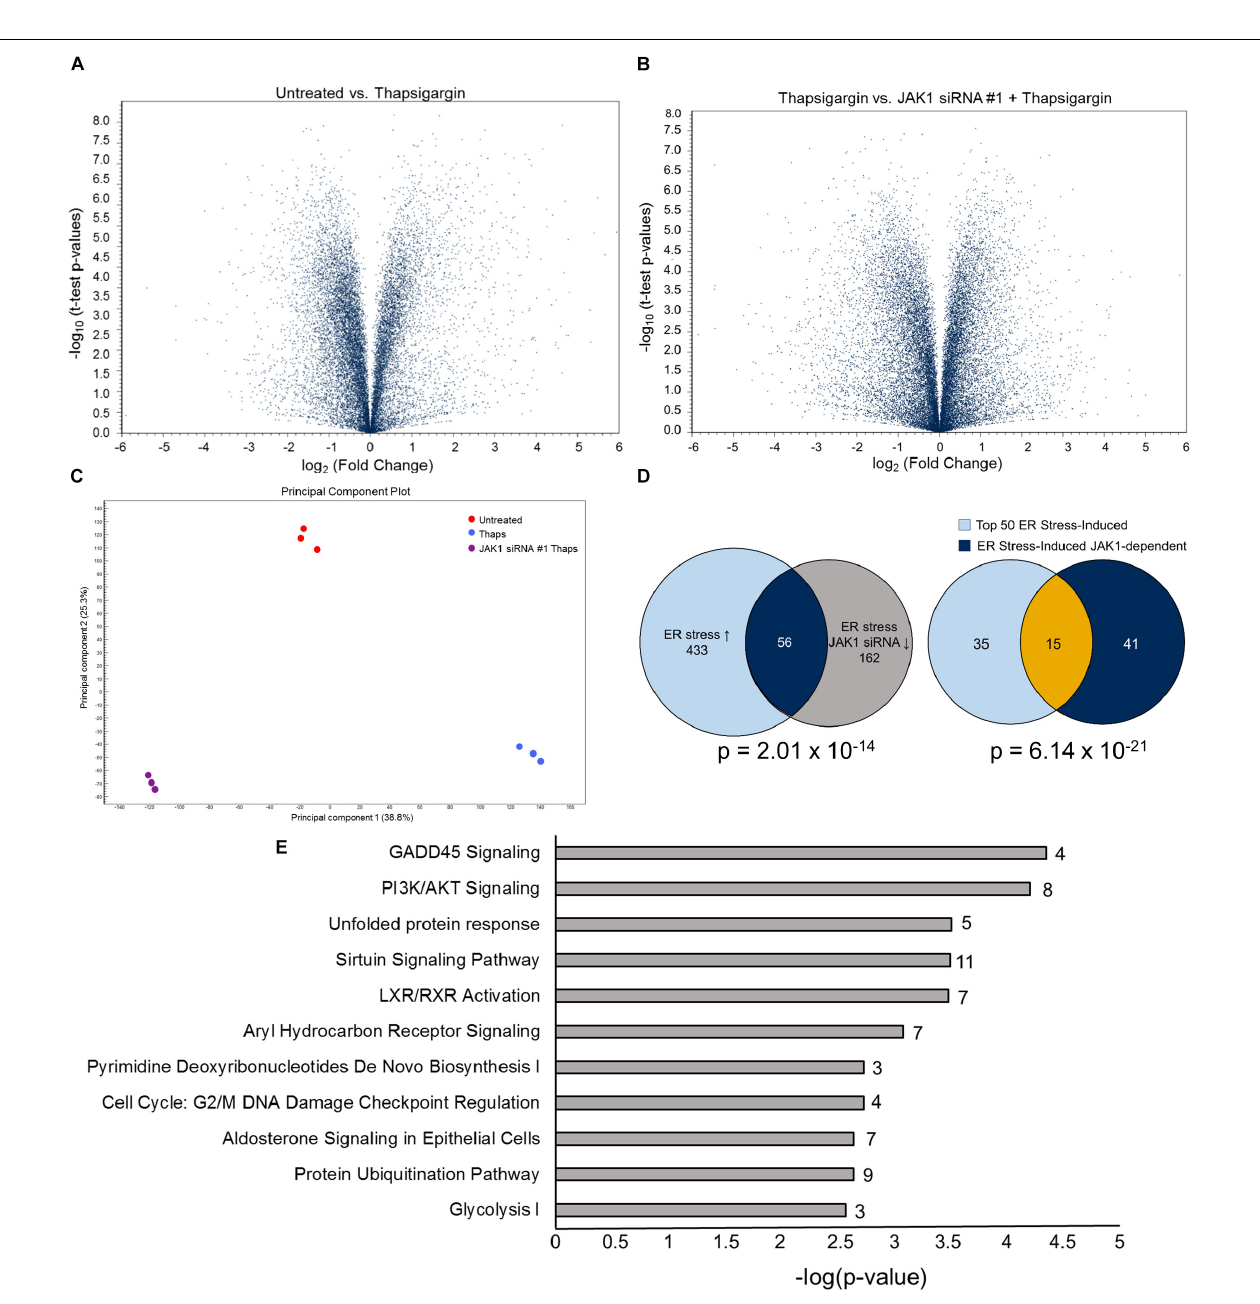
FIGURE 2 | JAK1 regulates approximately 10% of ER stress-induced gene expression. (A) Primary astrocytes were transfected with control (CTL) or JAK1 siRNA for 48 h followed by treatment with thaps (1 µ M) for 4 h and analyzed by RNA-seq. Volcano plots represent fold change and p -values for approximately 25,000 expressed genes. (B) Results were analyzed as in (A) between thaps-treated samples without or with JAK1 knockdown. (C) Principle Component Analysis (PCA) of RNA-seq treatment groups. (D) Venn diagram showing overlap of genes upregulated in response to thaps treatment and downregulated by JAK1 knockdown (left). Venn diagram of top 50 ER stress-induced genes overlapping with JAK1-dependent genes (right). (E) Functional classification of genes identified to be JAK1-dependent (Venn diagram overlap – 56 genes) in response to ER stress using Ingenuity Pathway Analysis. The number of JAK1-regulated genes in each pathway is indicated adjacent to each